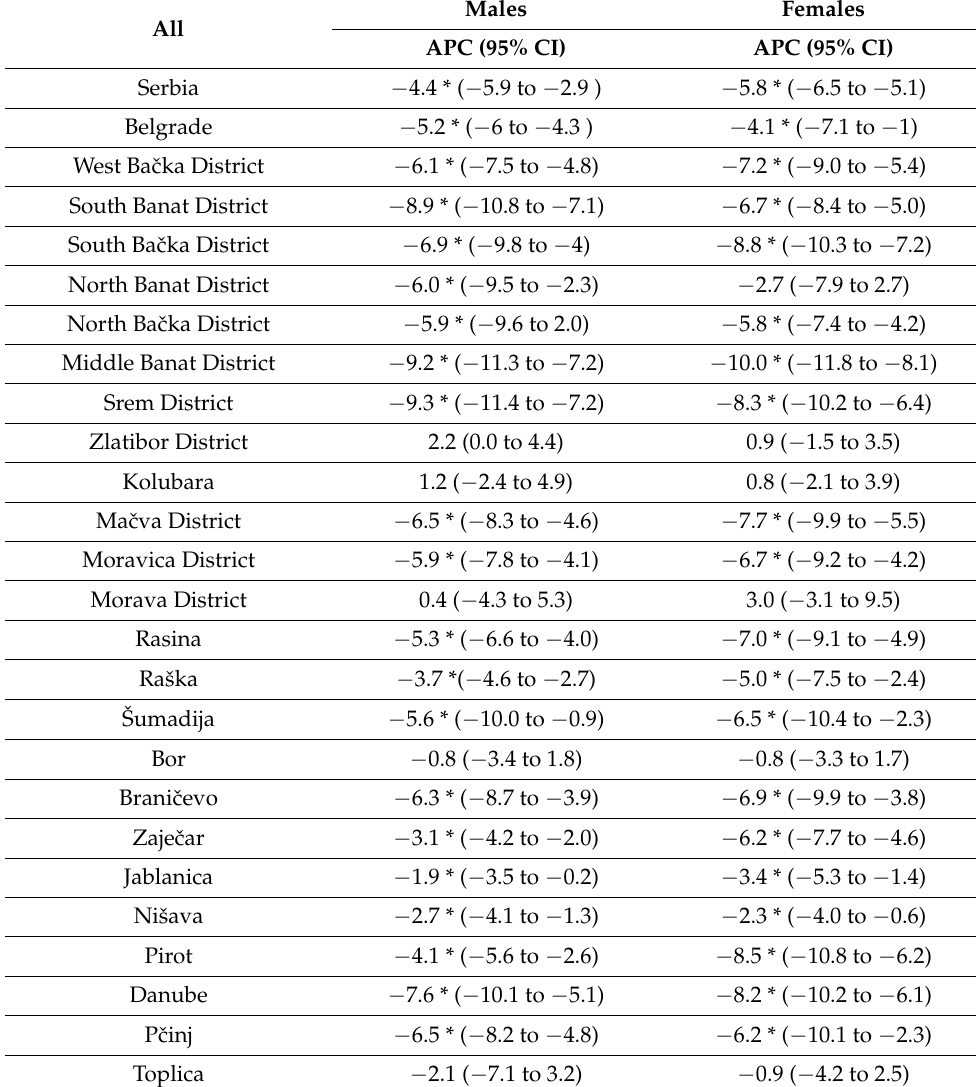
Table 3. Annual percent change for full period 2005–2019 in 25 districts in